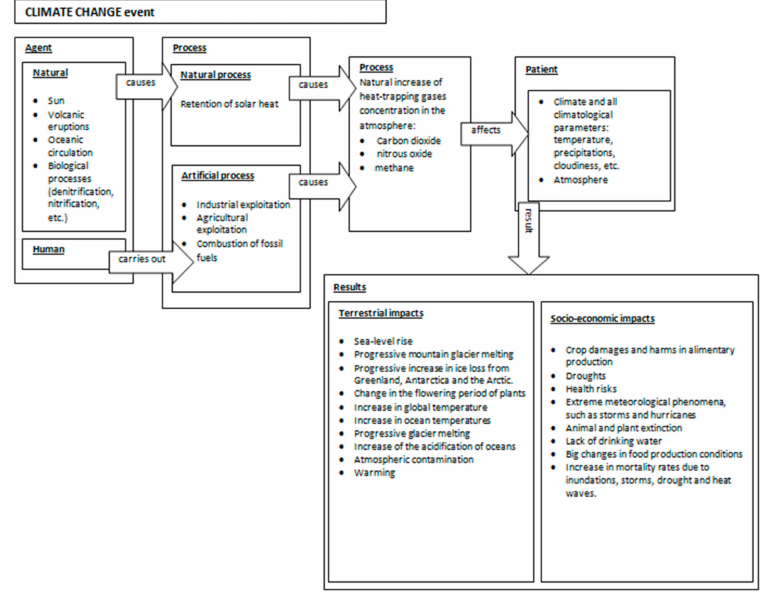
Figure 2. The CLIMATE CHANGE